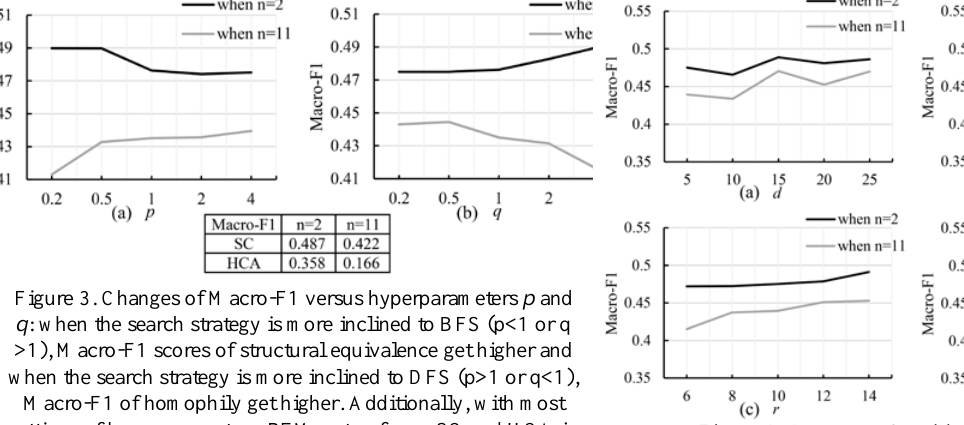
Figure 4. Parameter Sensitivity: the overall effect of parameters is positive: Macro-F1 scores are on the rise despite the fluctuations 1 .